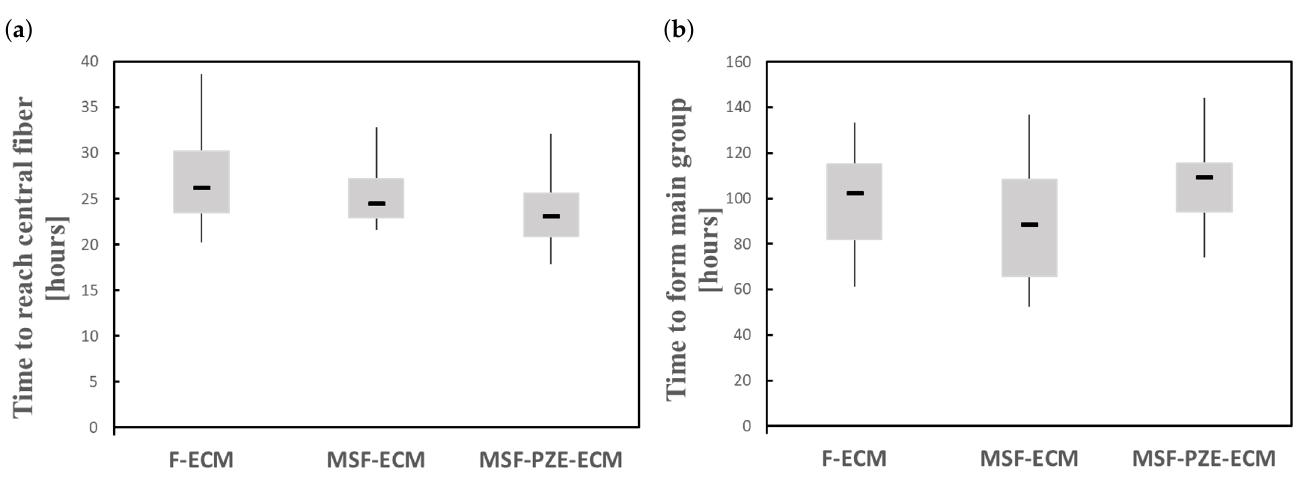
Figure 11. Numerical results under different stimulus configurations: Fibered ECM (F-ECM), Mechanically Stimulated Fibered ECM (MSF-ECM), and Mechanically Stimulated PZE Fibered ECM (MSF-PZE-ECM). ( a ) Time to reach the central fiber. ( b ) Time to join one main group (at least 55% of the